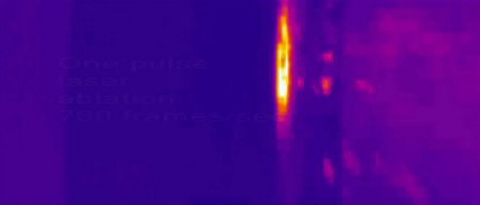
Figure 30. Ejection of excited, “hot” particles, registered during one pulse ablation of sandstone.